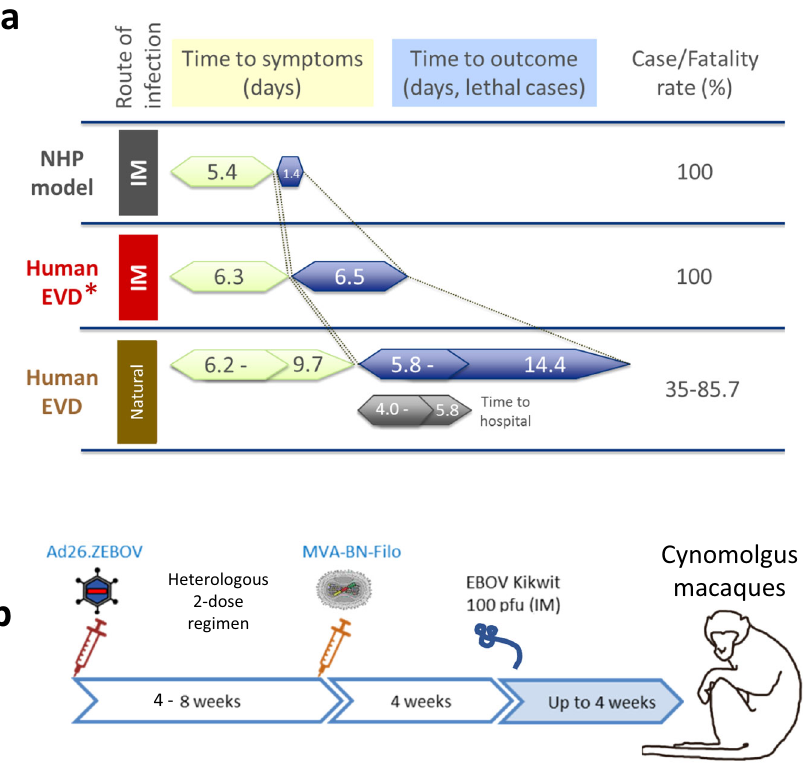
Fig. 1 Experiment schematic and comparison of Ebola virus disease course in NHP and humans. a The disease course and outcome of EVD was compared between untreated NHP and humans*. As far as the authors are aware, IM infection in humans via needle reusage is only identi fi ed in a single report 53 . There is rapid disease progression in NHP relative to humans, irrespective of route of infection. Duration indicated for NHP represents the average of 13 untreated controls from seven independent NHP studies (C25#1, 12, C29#1, C29#2, C29#8, TO14#1, TO14#2). In humans, time to symptoms, time to outcome, and time to hospital are based on cited papers 11 – 19 , and shown as the range of the mean values reported in the cited studies. Symptom onset in NHP was de fi ned based on recorded clinical score. b Experimental schematic of immunogenicity and ef fi cacy studies in NHP. Vaccine regimens containing Ad26.ZEBOV and MVA-BN-Filo were tested with variations in dose, dose interval, dose order, and valency of the adenovector vaccine. Four weeks after the fi nal vaccination, NHP were challenged with EBOV Kikwit (IM) at a target dose of 100 pfu (actual range 50 – 1615 pfu), and followed up for signs and symptoms of EVD for up to 4 weeks. EBOV Ebola virus, EVD Ebola virus disease, IM intramuscular, NHP nonhuman